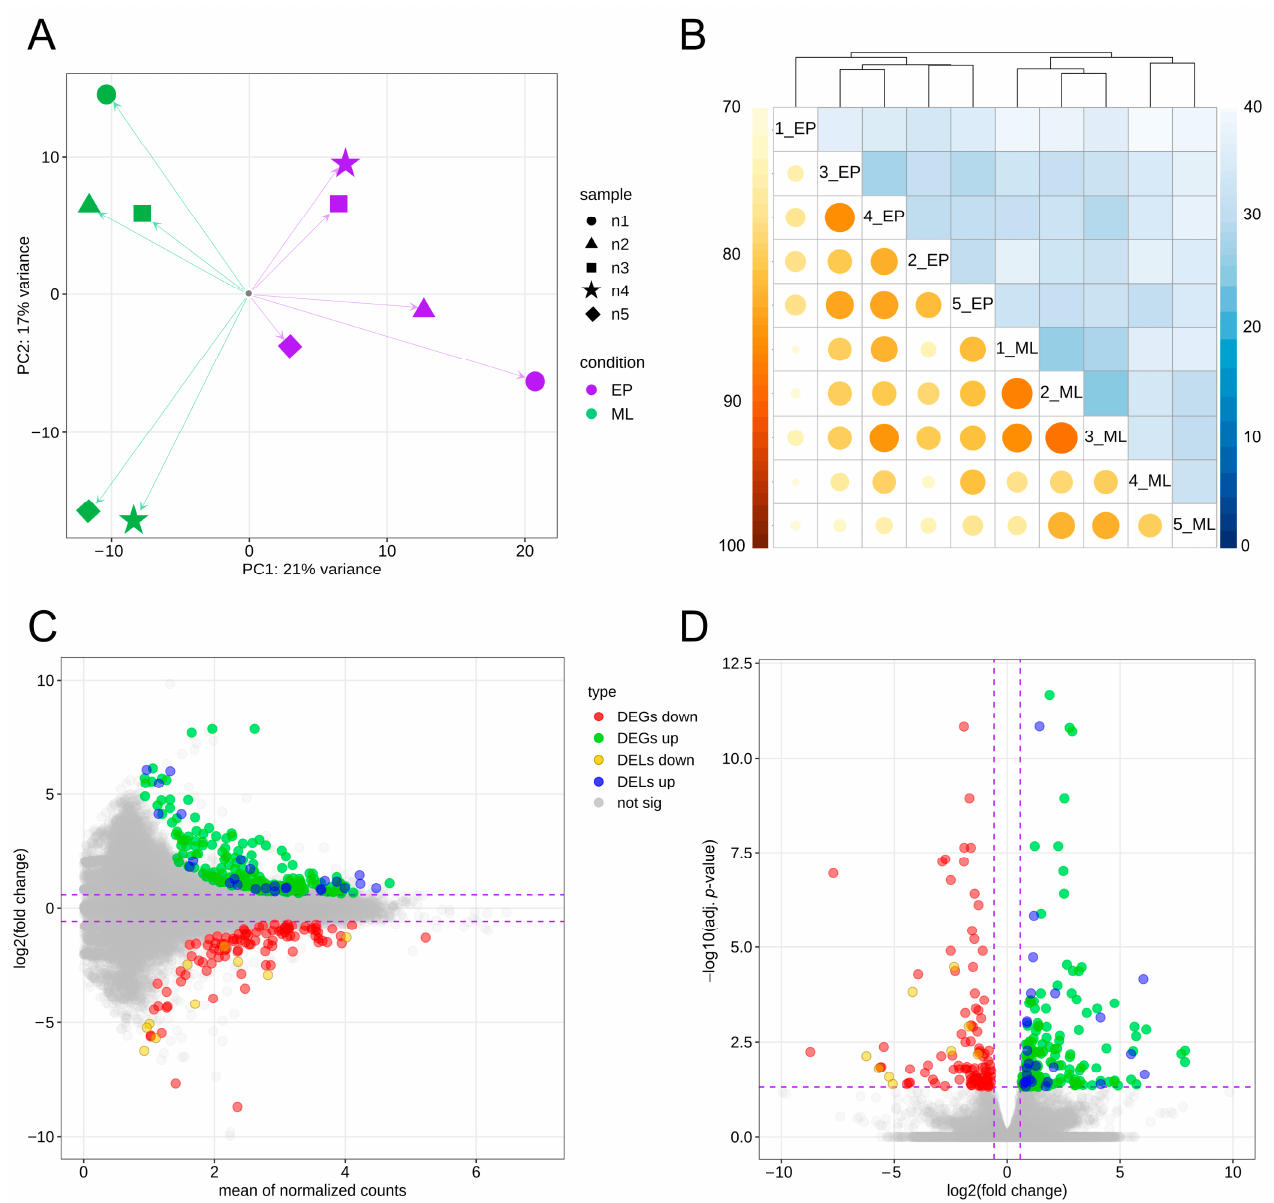
Figure 1. ( A ) Principal component analysis (PCA) of all differentially expressed genes. ( B ) Cluster analysis based separately on the Euclidean distance measure (blue part of the matrix) and Pearson correlation (orange part). The dendrogram characterizes the sample arrangement obtained in both analyses. ( C ) MA plot showing the mean of normalized counts values against log 2 (fold change) for DEGs and DELs comparing EP and ML groups. ( D ) Volcano plot presenting the log 2 (fold change) plotted against − log 10 (adjusted p -value) for DEGs and DELs between EP and ML libraries. The purple dashed lines indicate cut-off thresholds detailed in the text. Abbreviations: DEGs—differentially expressed genes, DELs—differentially expressed long noncoding RNAs, EP—the embryo implantation period of pregnancy, ML—the mid-luteal phase of the estrous cycle, not sig—not signi fi cant.